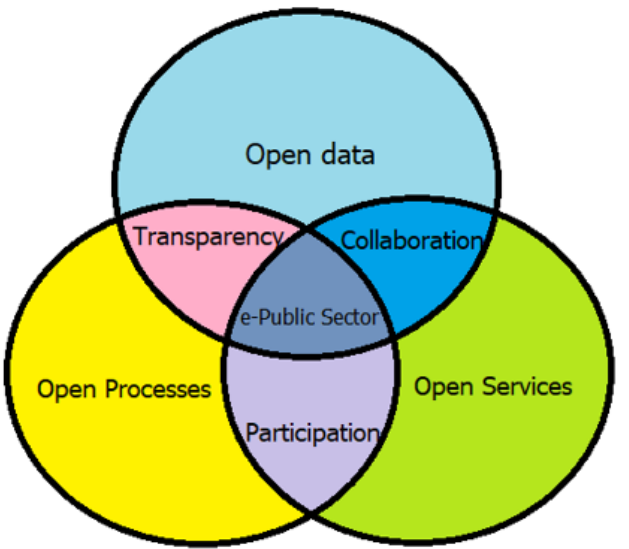
Figure 1. e-Public Sector Framework ( Crowdpolicy -